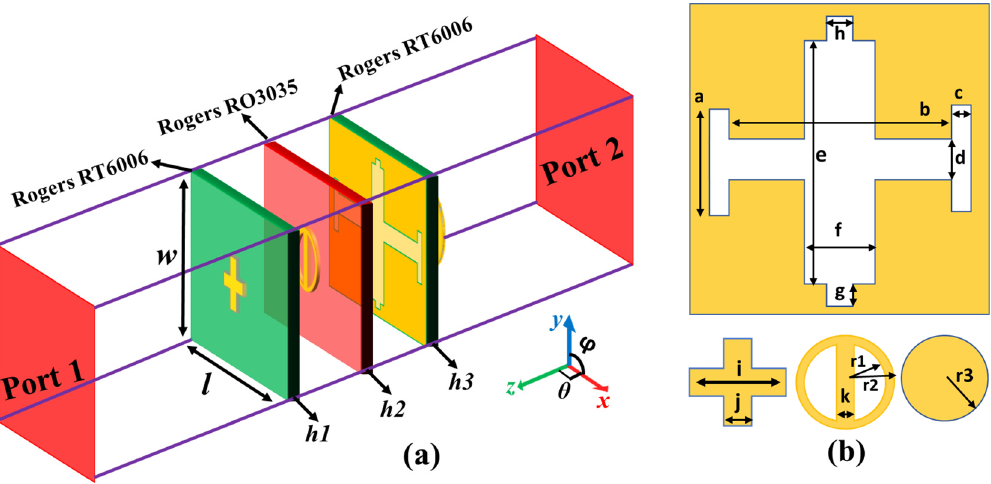
Figure 2. Structures and simulation setup of a unit cell. ( a ) Perspective view with its simulation setup. ( b ) Structure of four metal layers. l = 3 mm, w = 3.6 mm, h 1 = 0.8 mm, h 2 = 0.76 mm, h 3 = 0.8 mm, a = 0.5 mm, b = 2.3 mm, c = 0.15 mm, d = 0.2 mm, e = 1.7 mm, f = 0.45 mm, g = 0.15 mm, h = 0.15 mm, i = 0.8 mm, j = 0.2 mm, k = 0.2 mm, r 1 = 0.7 mm, r 2 = 0.5 mm, and r 3 = 0.5 mm.